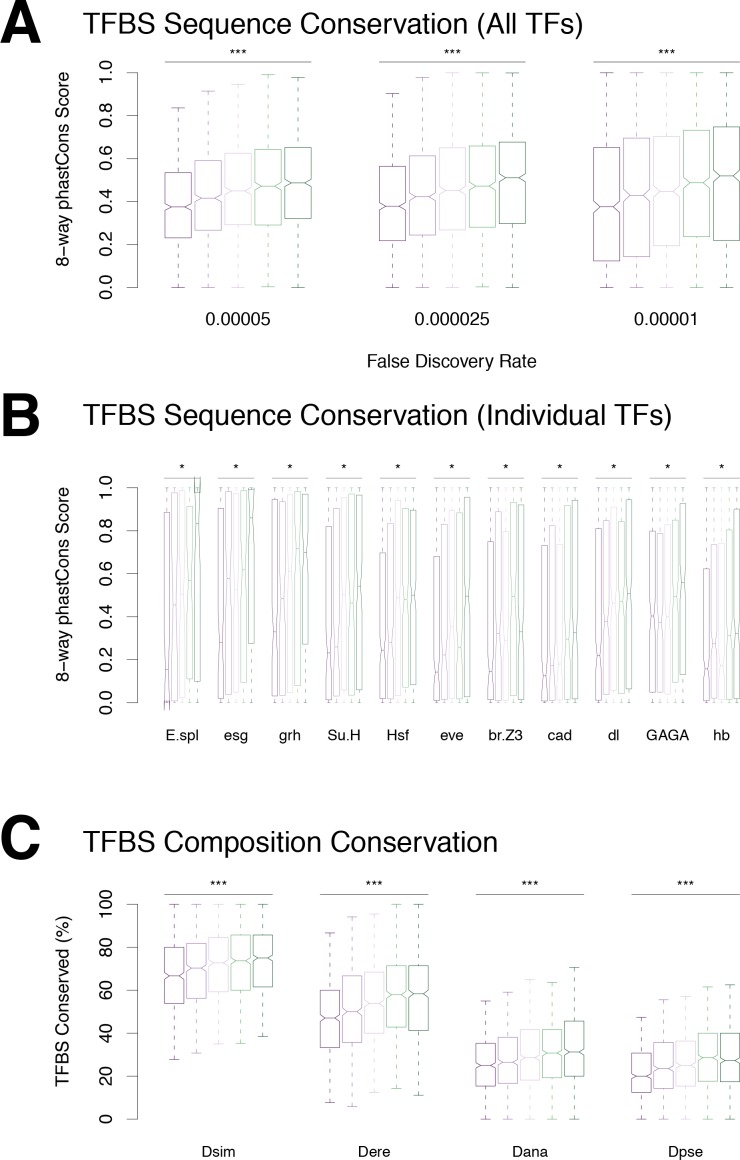
Conservation of transcription factor binding sites.(A) TFBS sequence conservation versus profile conservation. (B) Conservation of individual motif types. We found a significant correlation between motif sequence conservation and promoter profile conservation for 20 motif types (Bonferroni-corrected p-value<0.01). (C) Conservation of promoter TFBS composition, regardless of TFBS position.